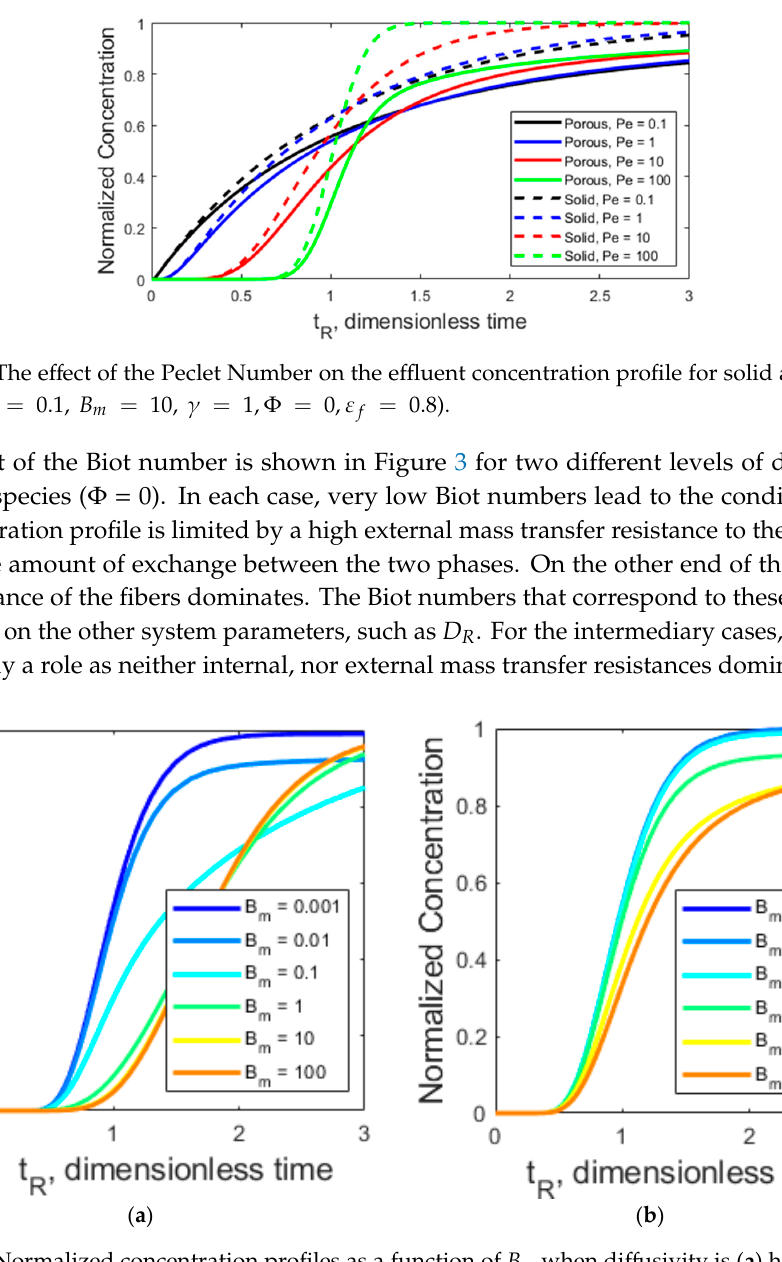
Figure 3. Normalized concentration profiles as a function of B m when di ff usivity is ( a ) high, D R = 10 and ( b ) low D R = 0.1 ( Pe = 20, B m = 10, γ = 1, Φ = 0, ε f = 0.8 ).